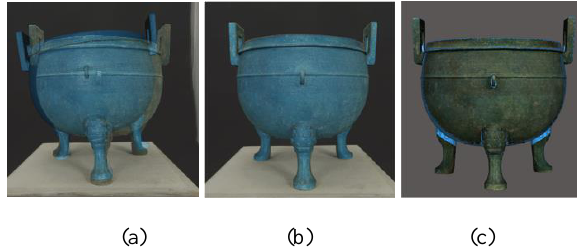
Figure 12: Results of Target Extraction and Texture Mapping.